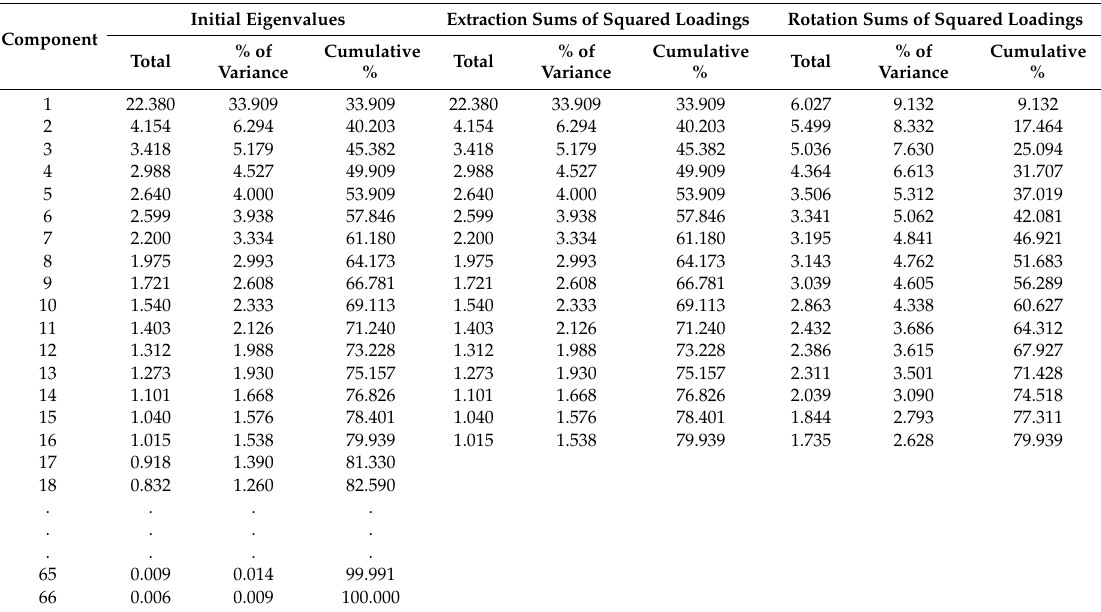
Table 3. Total variance explained for risk